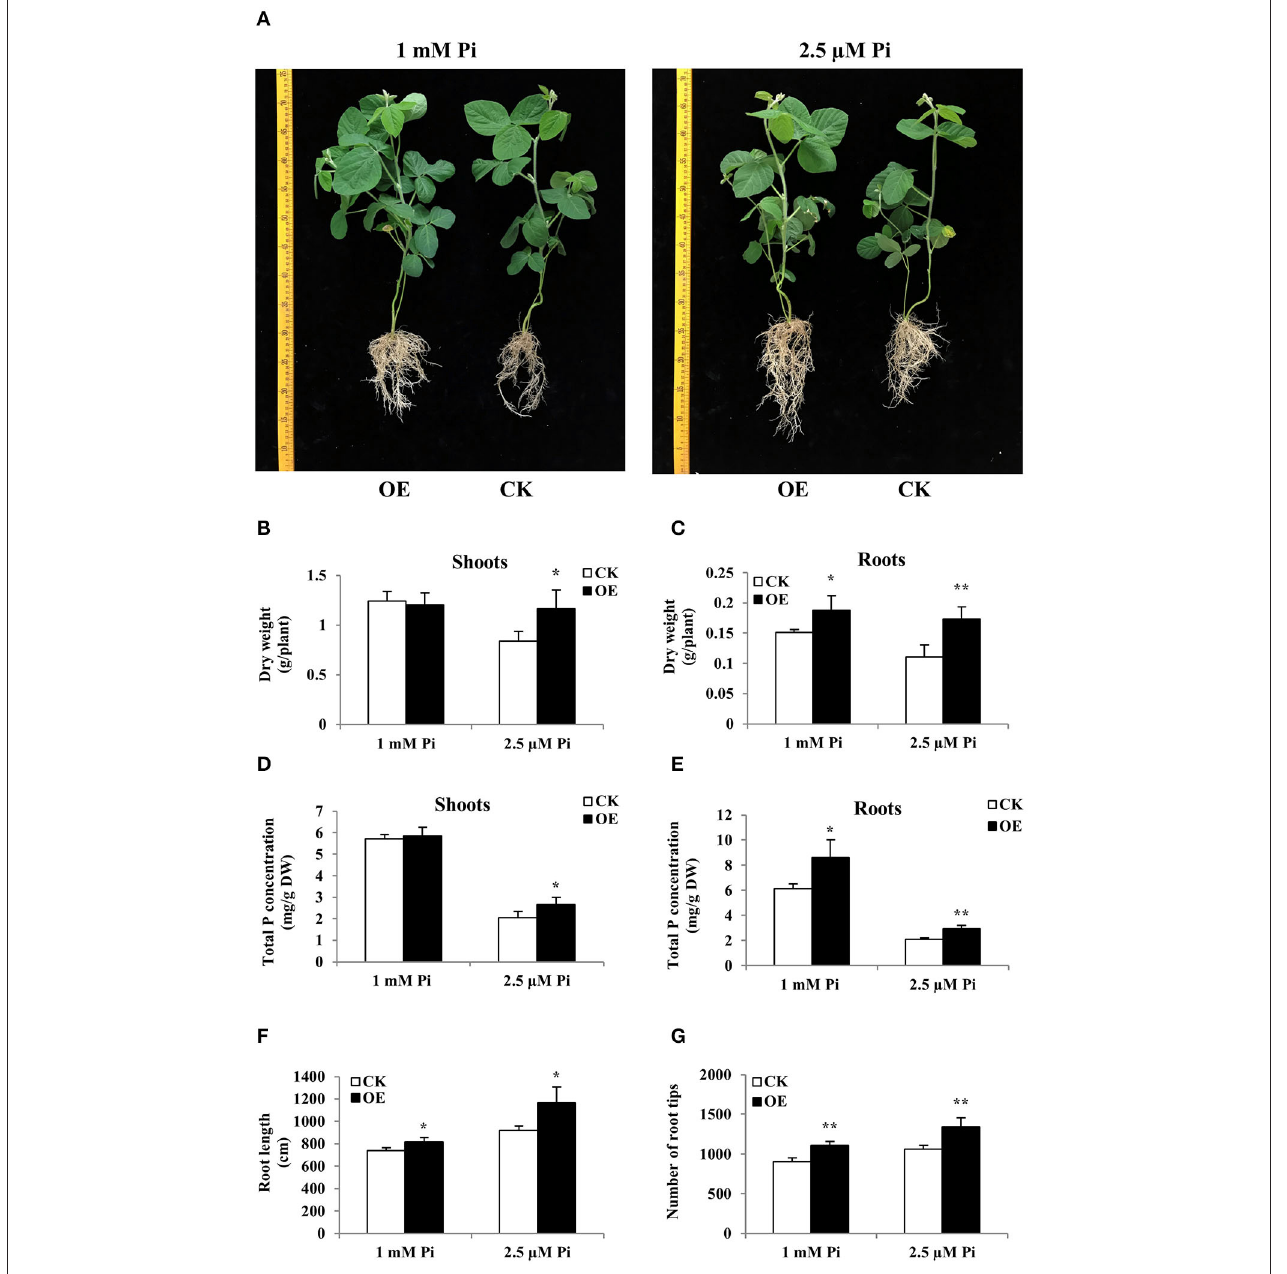
FIGURE 8 | Comparison of control (CK) and GmWRKY46 -overexpressing composite soybean plants (OE) under two Pi level conditions. Composite soybean plants with transgenic hairy roots were transferred to a nutrient solution containing 1mM Pi (Pi-sufficient) or 2.5 µ M Pi (Pi-deficient). After a further 14 days, shoots and roots were separately harvested for analysis. (A) Phenotype of CK and OE. Scale unit: cm. (B) Dry weight of shoots. (C) Dry weight of roots. (D) Total P concentration of shoots. (E) Total P concentration of roots. (F) Root length of composite plants. (G) Number of root tips of composite plants. CK represents the composite plants transformed with the empty vector; OE indicates composite plants with GmWRKY46 -overexpressing transgenic hairy roots. DW means dry weight. Data are means ± SD of three biological replicates. Asterisks indicate significant differences between OE and CK (Student’s t -test, * P < 0.05; ** P < 0.01).